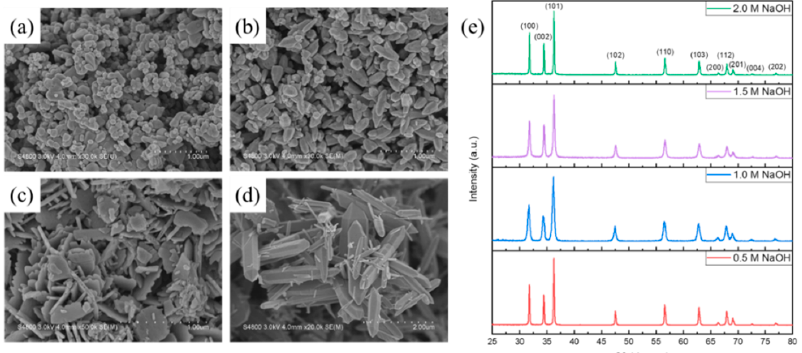
Figure 3. The SEM images of prepared ZnO nanomaterial were obtained by adjusting the NaOH concentration: ( a ) 0.5 M, ( b ) 1.0 M, ( c ) 1.5 M, and ( d ) 2.0 M, respectively. ( e ) the XRD diffraction patterns of ZnO are prepared by preparing different NaOH concentrations.